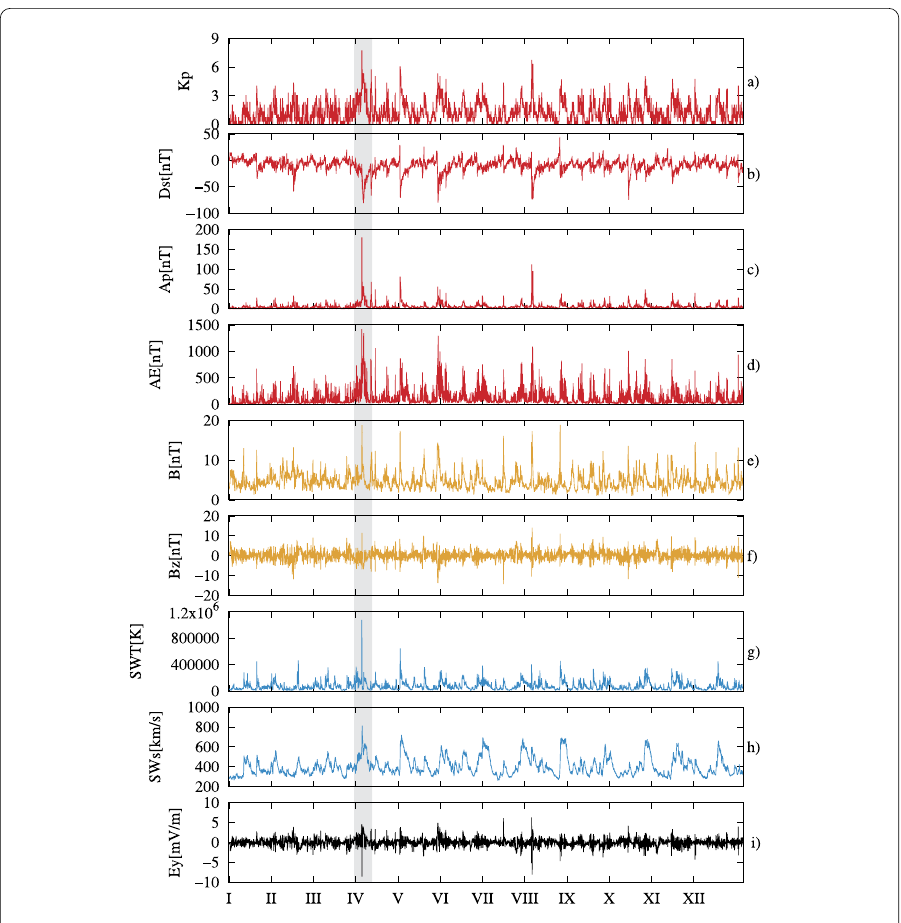
Figure 3 Hourly data of geomagnetic indexes: ( a ) Kp , ( b ) Dst , ( c ) Ap , ( d ) AE ; heliospheric magnetic field: ( e ) strength, ( f ) Bz component; solar wind: ( g ) temperature, ( h ) speed; and ( i ) electric field in